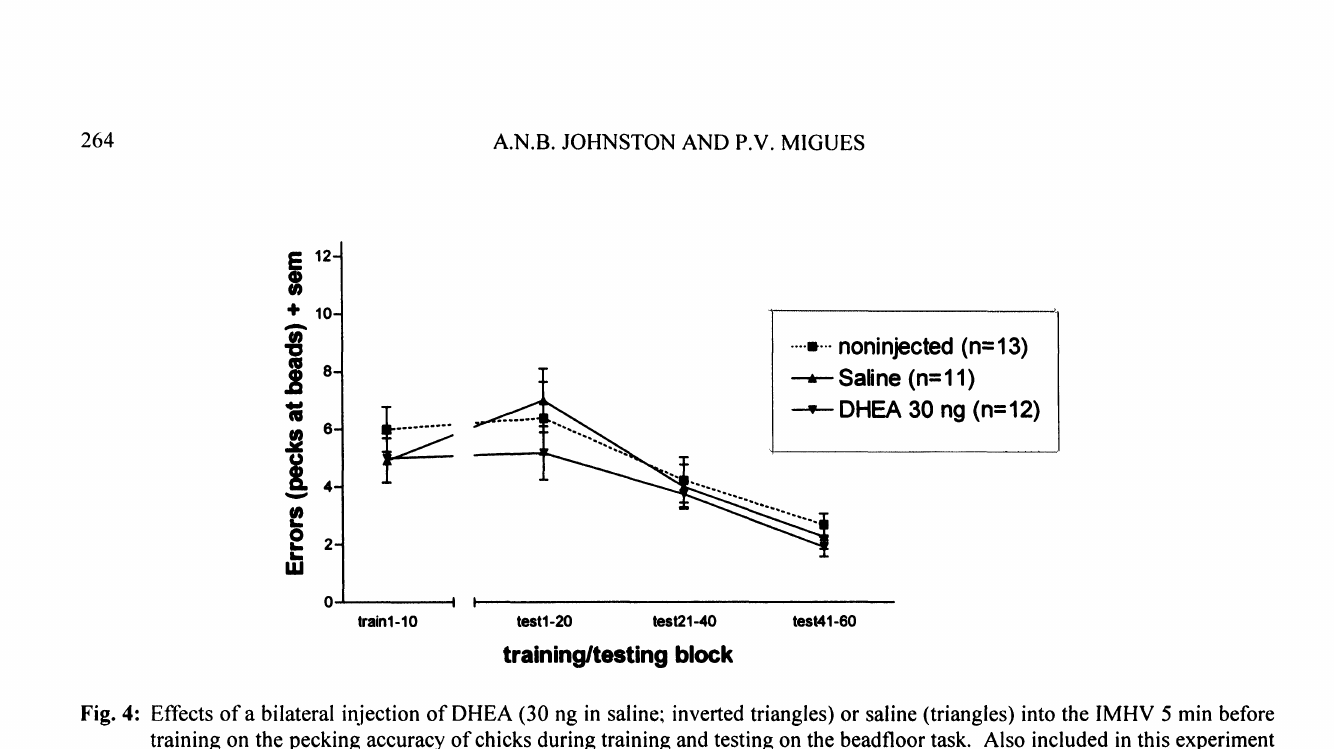
Fig. 4: Effects of a bilateral injection of DHEA (30 ng in saline; inverted triangles) or saline (triangles) into the IMHV 5 min before training on the pecking accuracy of chicks during training and testing on the beadfloor task. Also included in this experiment is data from a non-injected group of chicks (squares). Data are analysed and presented as in Fig. 2. Note however that the training block was reduced to 10 pecks, n values vary and are given in the legend